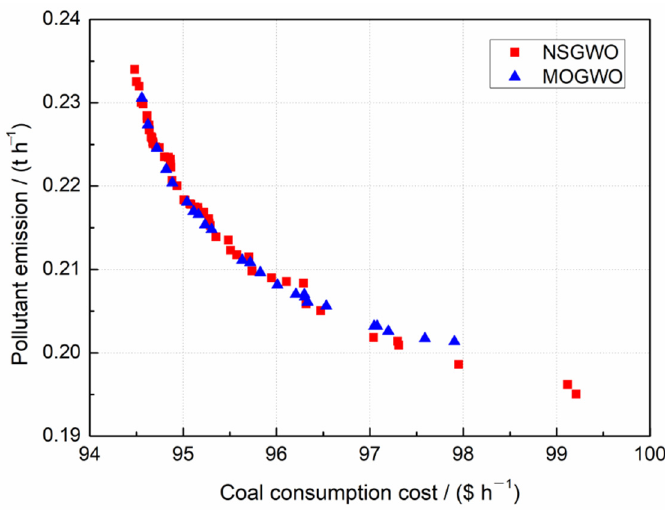
Figure 4. Pareto fronts of coal-consumption cost and pollutant emissions of load-dispatch optimiza- tion under NSGWO and MOGWO algorithms.